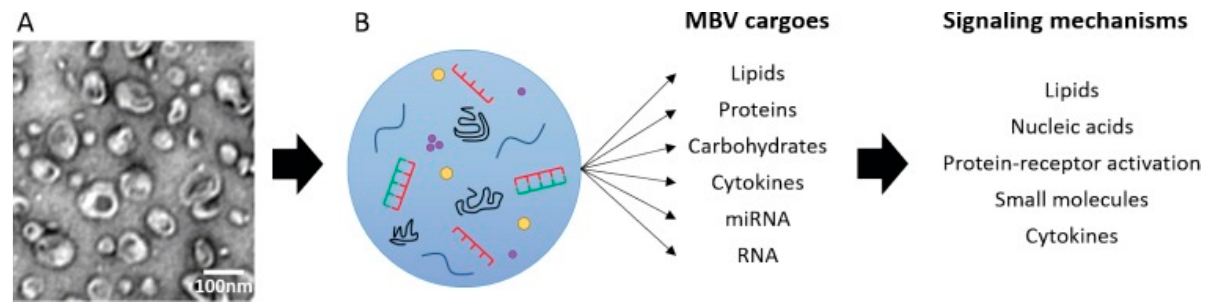
Figure 3. MBV carry diverse cargoes that can signal via multiple mechanisms. Reprinted with per- mission from Ref. [53]. Copyright 2022 Wolters Kluwer Medknow